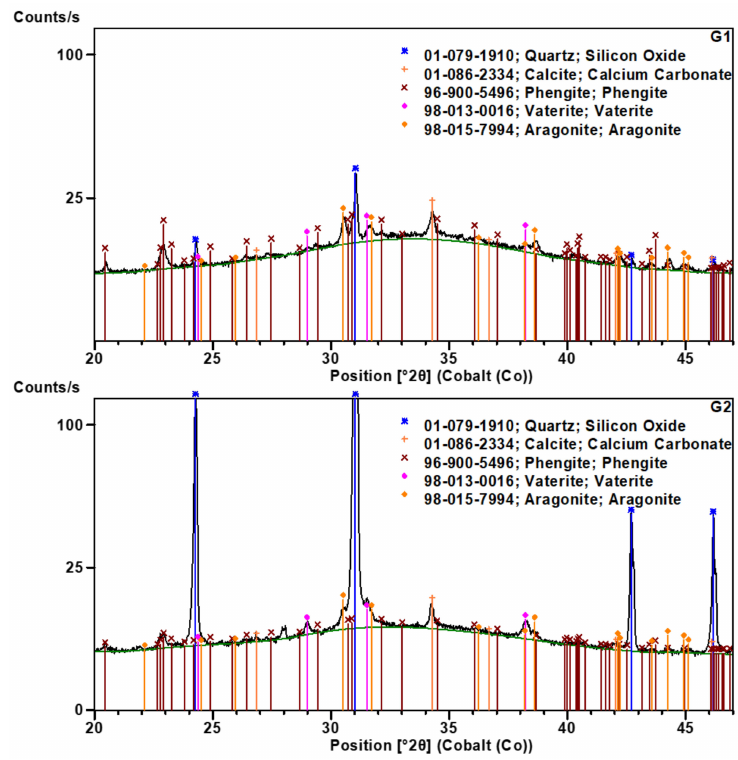
Figure 10. XRD patterns of the G1 and G2 matrices.